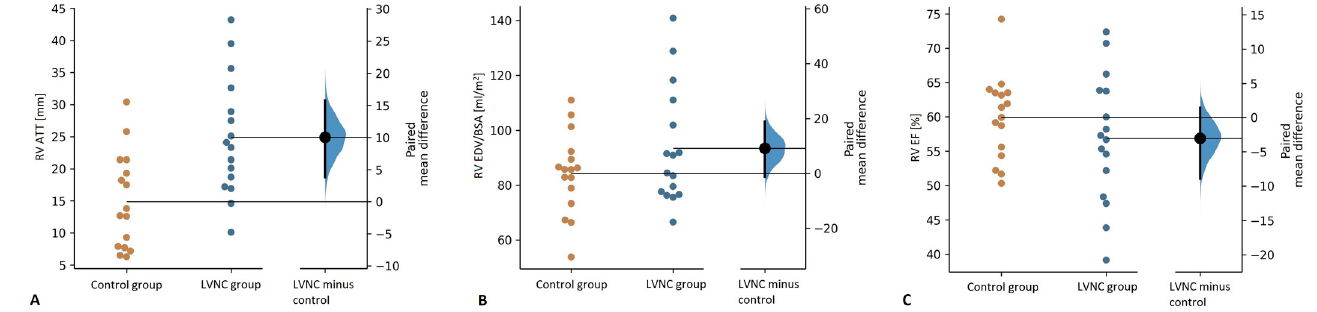
Figure 5. Comparison of right ventricular apical trabeculation thickness (RV ATT) ( A ), end-diastolic volume indexed for body surface area (RV EDV/BSA) ( B ), and ejection fraction (RV EF) ( C ) between the control and the LVNC group.